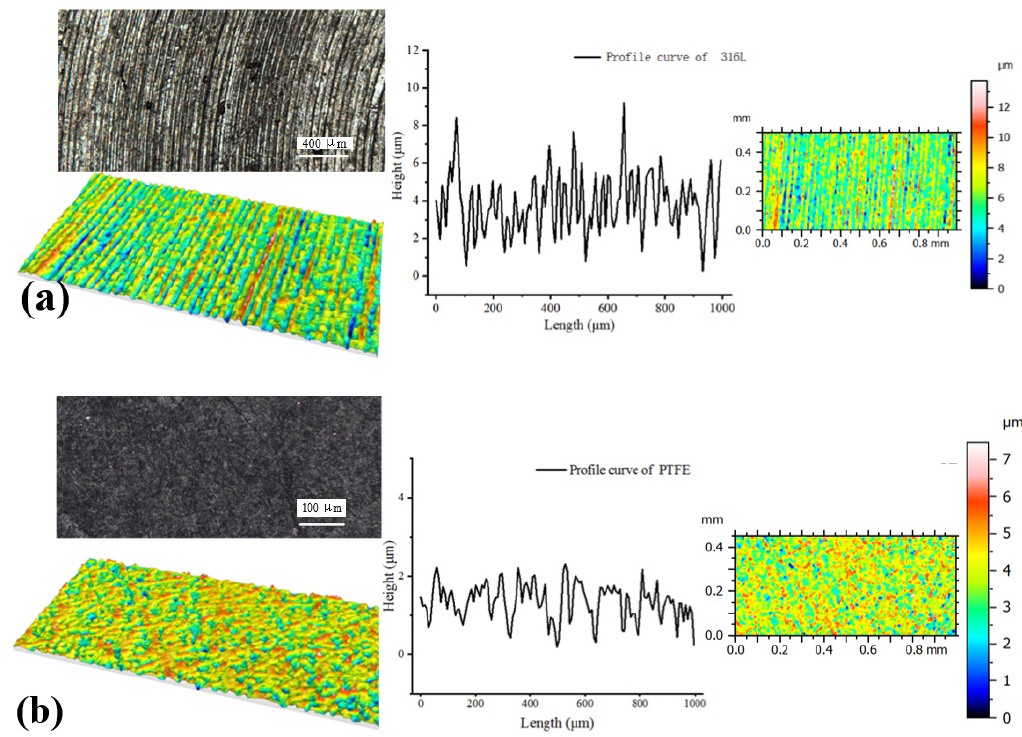
Figure 3. The morphology and profile curves of turned 316L and PTFE: ( a ) turned 316L sample, ( b ) PTFE sample.